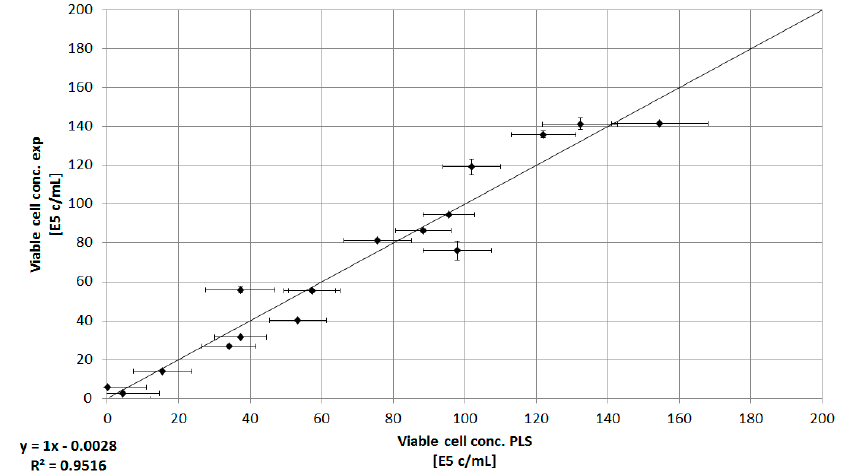
Figure 6. Correlation between offline viable cell concentration (E5 cells/mL) determination and PLS (NIPALS)-based viable cell concentration (E5 cells/mL). Error bars represent the double determination of cell concentration, as well as the model error (RMSE ≤ 13.82). The coefficient of determination for this linear relation is >0.95.